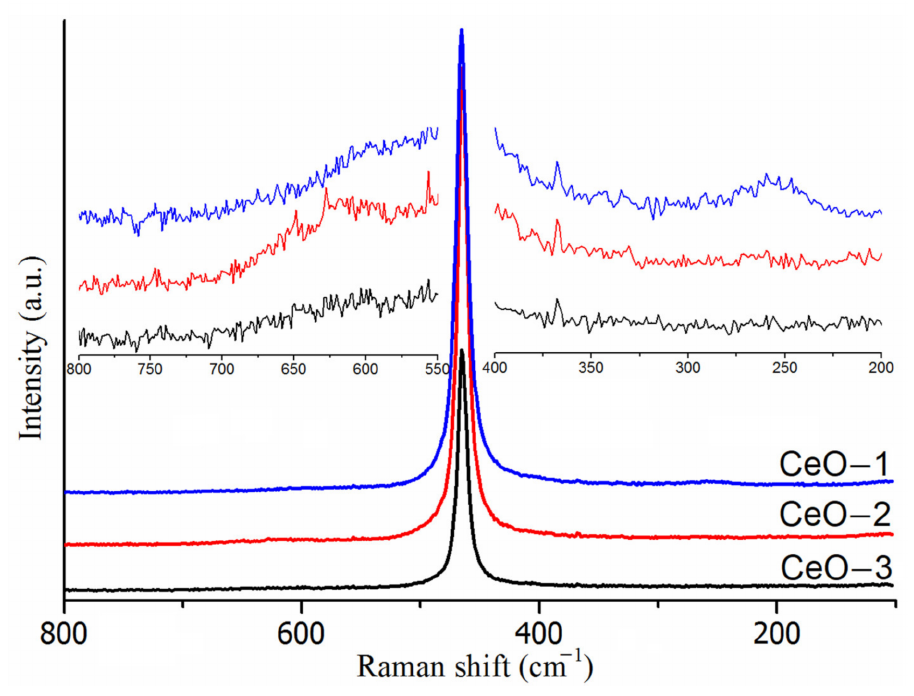
Figure 1. Raman spectra of cerium oxide